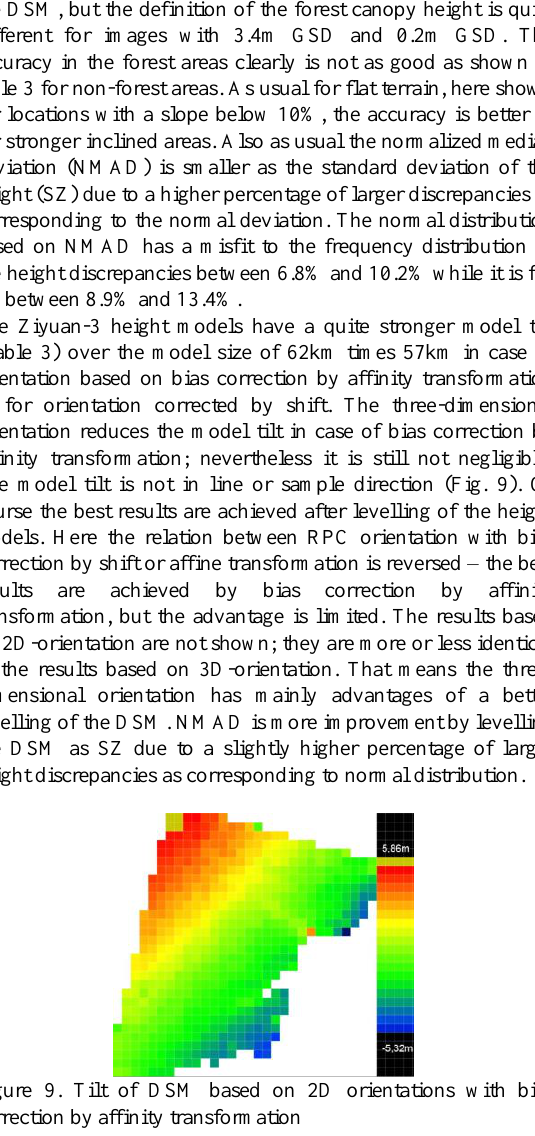
Figure 12. Systematic height errors of Ziyuan-3 DSM based on bias correction by affinity transformation